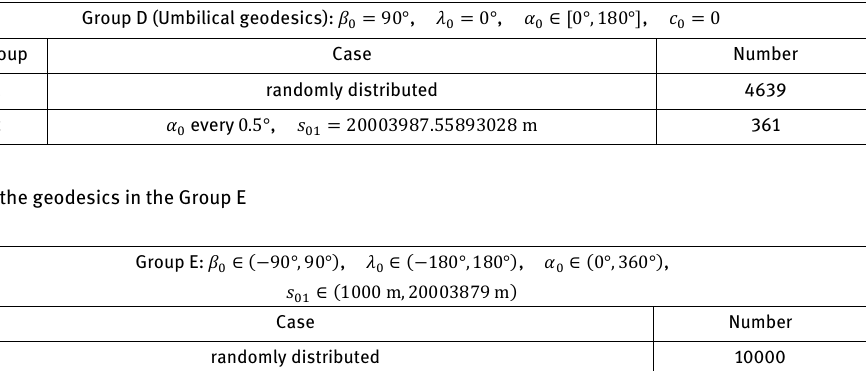
Group D (Umbilical geodesics): 𝛽𝛽 0 = 90°